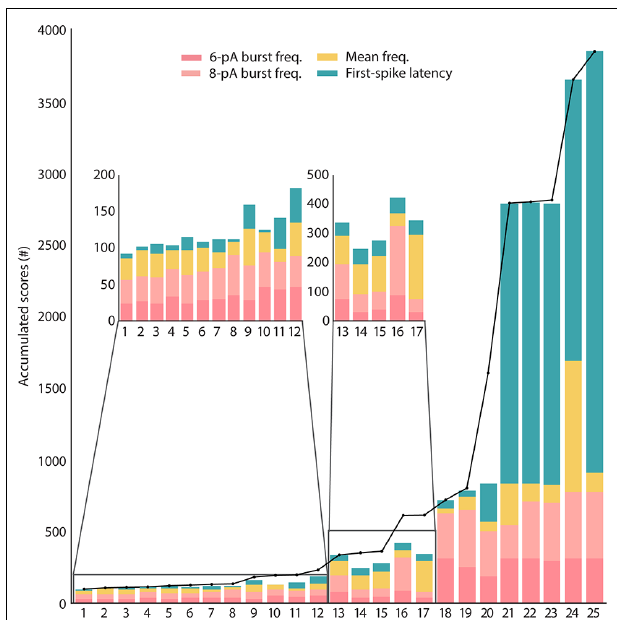
FIGURE 4 | Scores of the candidate solutions. The total scores obtained from minimizing the features of the candidates according to the objective function are represented in black dots joined together by a black line. These total scores are unwrapped by the scores of each single feature (feature scores) for every candidate solution and represented in stacked bars. The feature calculations are explained in “Model Context and Problem Definition” section. The feature of burst frequency (pink bar plots) has been divided based on the sinusoidal stimulation amplitude of 6 pA or 8 pA (the standard deviation has not been included in the stacked